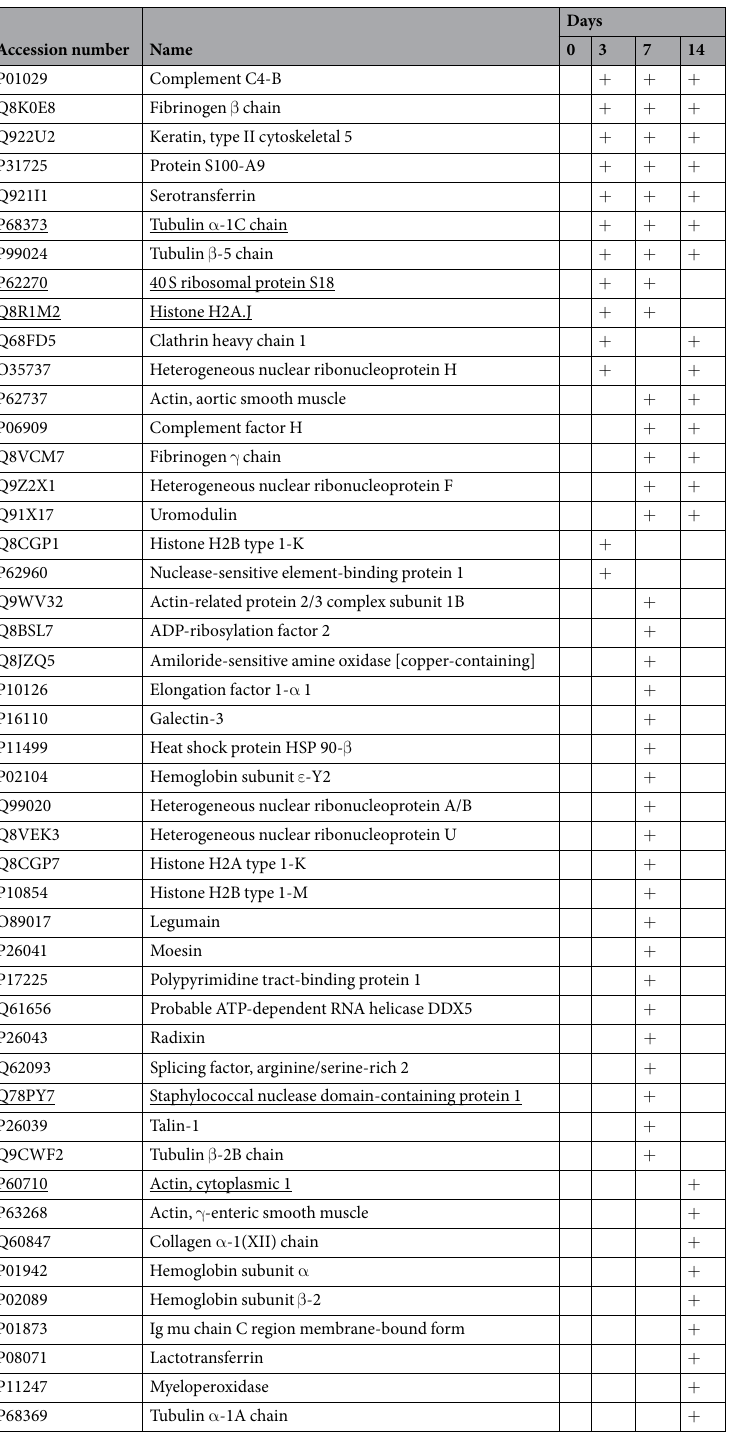
Table 1. Identified possible substrates for TG1 using pepK5. Kidney extract on each indicated day after UUO surgery was incubated with biotinylated pepK5. The newly identified possible substrates in each indicated day were demonstrated as “ + ” compared to control sample (Day 0). The underlined possible substrates indicate overlapped substrates identified as both peptide (pepK5 and pepT26)-incorporated proteins. This Each experiment was done with two replicates from three independent